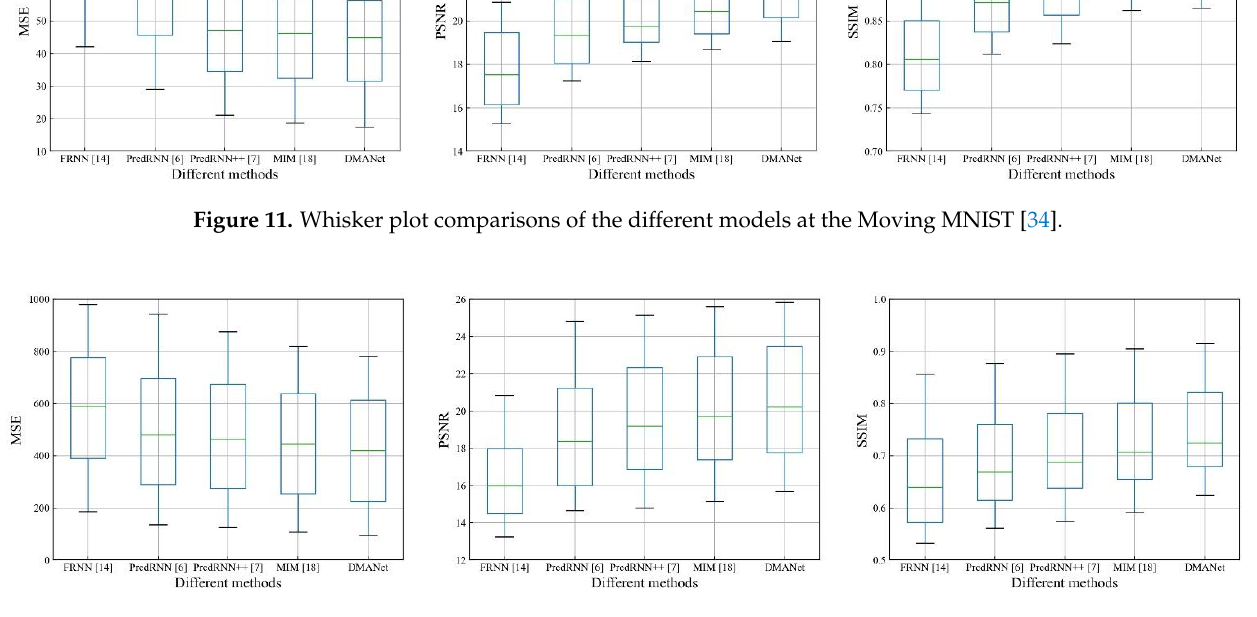
Figure 13. Whisker plot comparisons of the different models at the AR Map. Figures 14–16 shows frame-by-frame quantitative experiments for the 10 frames at the chose datasets. It can be seen that the developed method has the best performance among the investigated methods with the lowest MSE, both the highest PSNR and SSIM at each frame.